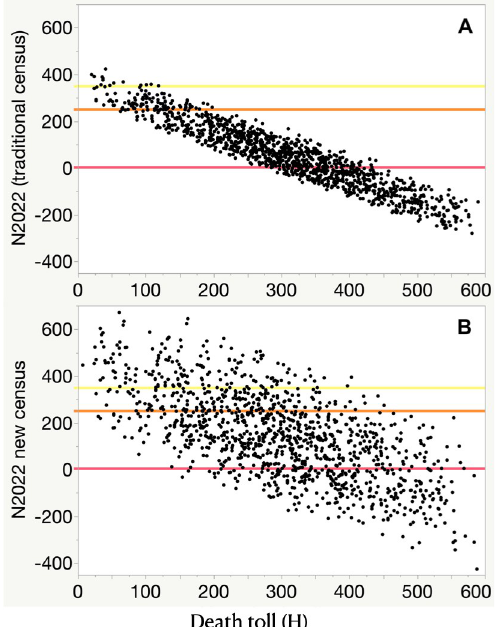
Fig 3. The relationship between wolf-hunt death tolls in Fall 2021 (x-axis) and predicted wolf population status in Wisconsin on 14 April 2022 (y axis). Ordinary least squares regression of N 2022 against H for the traditional census method (A, regression line not shown adjusted r 2 = 0.89, N 2022 = 366–1.016 � H, SE slope = 0.010) and new census method (B, regression line not shown adjusted r 2 = 0.45, N 2022 = 437–0.983 � H, slope SE = 0.032). We ran 3600 iterations for each panel, in which we randomly selected 1200 values for each parameter in Eqs 1 and 2. Three reference lines represent the legal thresholds of 1 (extirpation, red), 250 (state listing, orange), and 350 (state population goal,